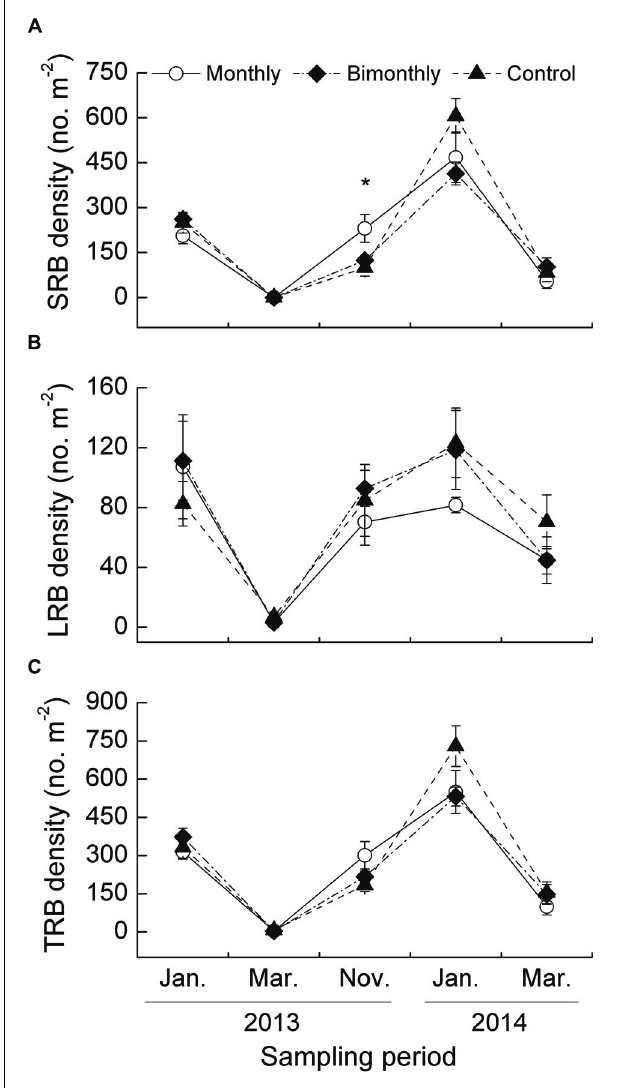
FIGURE 3 | Short rhizome bud (SRB, A), long rhizome bud (LRB, B), and total rhizome bud (TRB, C) density of C. brevicuspis populations for three defoliation frequencies, January 2013–March 2014. Different scales are used on the y -axis. The data are expressed as the mean ± standard error (SE). ∗ p < 0.05.